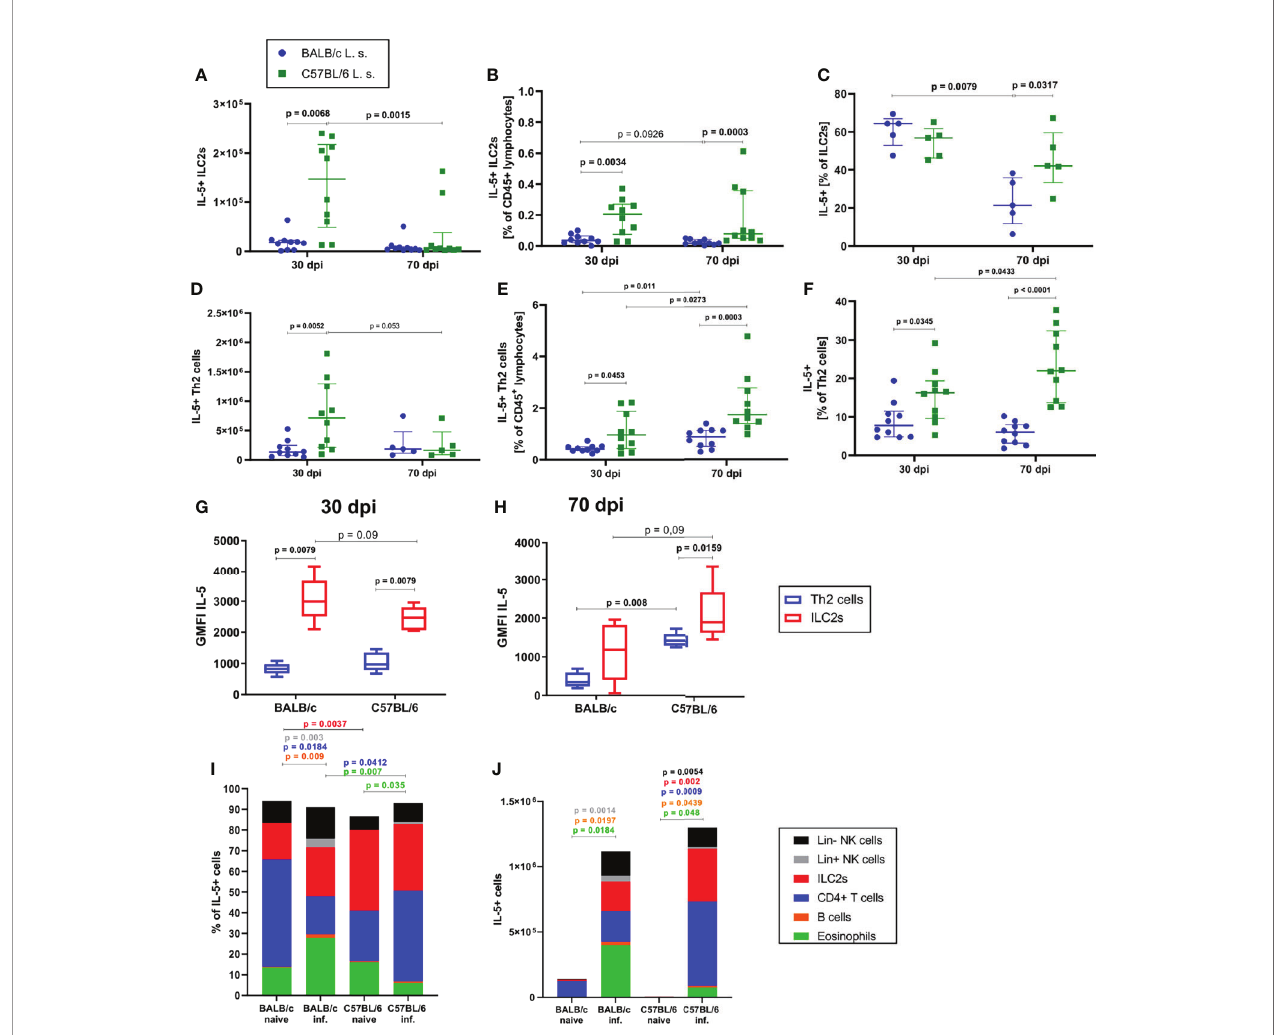
FIGURE 3 | ILC2s are more potent in producing IL-5 than CD4 + T cells during L. sigmodontis infection. (A) Total IL-5 + ILC2 cell count in the pleural cavity of naturally L. sigmodontis -infected susceptible BALB/c and semi-susceptible C57BL/6 mice at 30 and 70 days after infection (dpi). (B) IL-5 + ILC2 frequency of CD45 + lymphocytes and (C) IL-5 + ILC2s frequencies of ILC2s in the pleural cavity. (D) Total IL-5 + Th2 cell count in the pleural cavity of naturally L. sigmodontis -infected susceptible BALB/c and semi-susceptible C57BL/6 mice 30 and 70dpi. (E) IL-5 + Th2 cell frequency of CD45 + lymphocytes and (F) IL-5 + Th2 cells frequency of CD4 + T cells in the pleural cavity. IL-5 expression (GMFI) of ILC2s and Th2 cells in 30 day (G) and 70 day (H) L. sigmodontis -infected BALB/c and C57BL/6 mice. (I) Composition of IL-5 + cells (shown as frequencies) in the pleural cavity of naïve mice and at 30dpi. (J) Composition of IL-5 + cells (shown as total numbers) in the pleural cavity of naïve mice and at 30dpi. (A, B, D – F) n = 10 mice, pooled data from 2 independent experiments per time point. (C) n = 5 mice, data shows 1 representative experiment from 2 independent experiments per time point. (G, H) n = 5 mice, data shows 1 representative experiment from 2 independent experiments. (I) n = 5 mice, data from